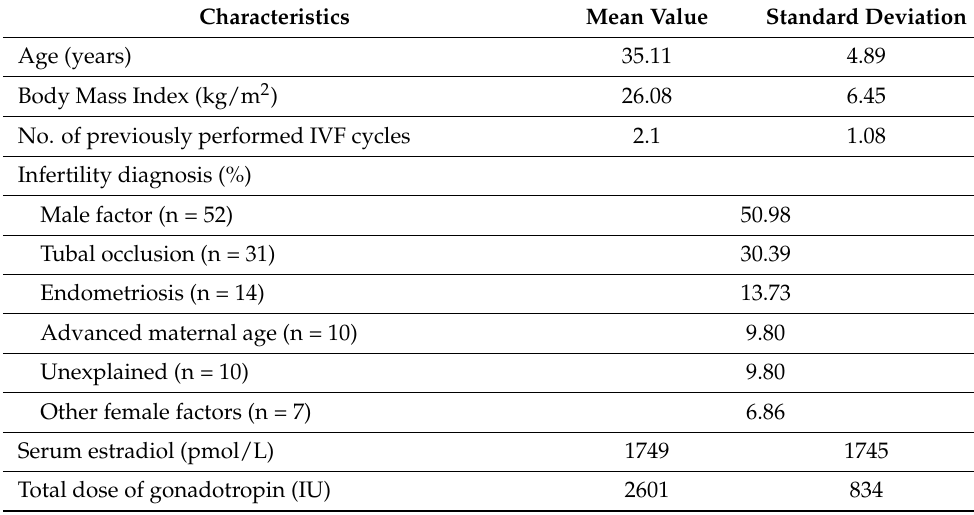
Table 1. Descriptive statistics of the patients